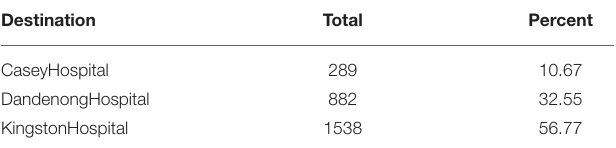
TABLE 5 | The estimated case load per center, based on combination of per postcode prediction based on demographics and assignment based on distance